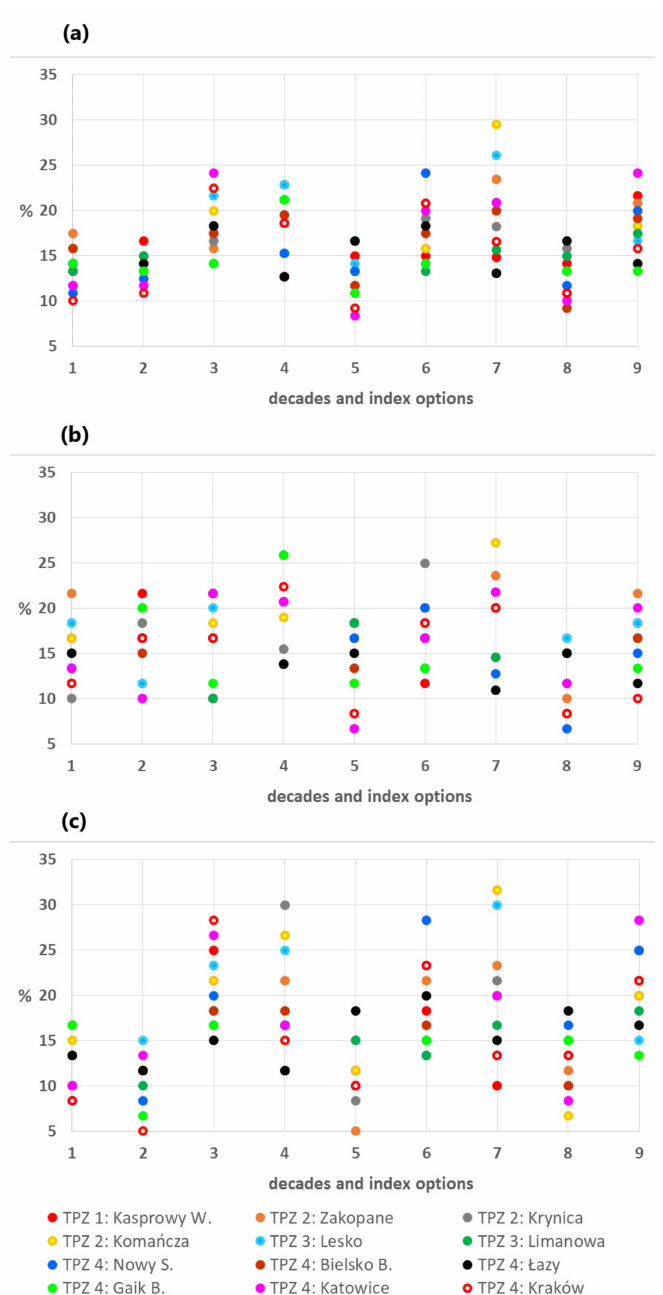
Figure 5. Percentages of dry months according to SPI (SPI ≤ − 1.0) for 1-, 3- and 6-monthly timescales, for the whole year ( a ) and for the subperiods May–October ( b ) and November–April ( c ) in the decades of the study period. Stations are ordered following the concept of TPZ explained in Section